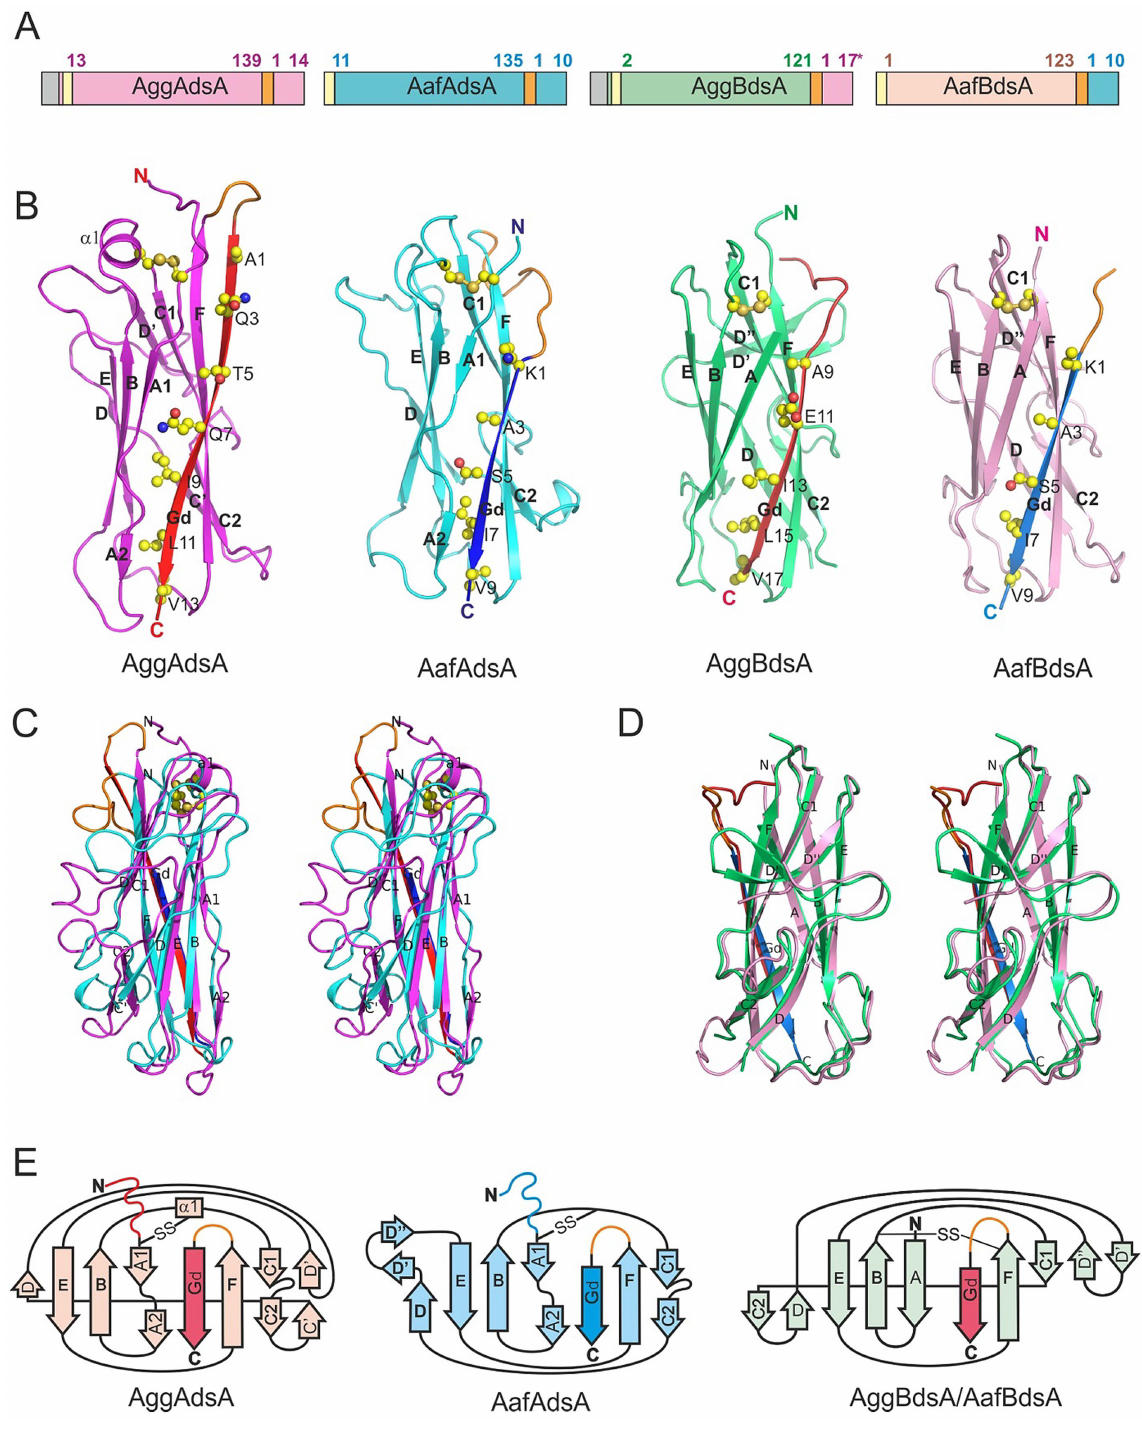
Figure 2. High-resolution structures of DSC subunits of AAF type I and II. (A) Schematic representation of DSC monomers. The positions of residues flanking mature sequence are numbered. Signal peptide, N-terminal His-tag, and linker are colored in grey, yellow and orange, respectively. For AggBdsA, both donor strand sequences of AggA from the German outbreak strain and classical EAEC strain 17–2 (three residue longer) were used successfully to stabilize AggB, however only the later crystallized. Amino acid sequences of the constructs are shown in Fig. S2. (B) Cartoon diagrams of AggAdsA, AafAdsA, AggBdsA and AafBdsA. (C and D) Structural superposition of AggAdsA and AafAdsA (C) and AggBdsA and AafBdsA (D) (stereo view). (E) Topology diagrams. The core structure of AggAdsA, AafAdsA, AggBdsA and AafBdsA is painted in magenta, cyan, green, and pink, respectively. The AggA and AafA Gd donor strands are colored in red and blue, respectively. The loop linking the core structure and donor strand (visible in AggAdsA, AafAdsA and AafBdsA) is shown in orange. Donor strand residues and disulfide bonds are shown as balls and sticks in A. Carbon, oxygen, nitrogen, and sulfur atoms are painted in yellow, red, blue and orange, respectively. Secondary structure elements are labeled in A and B.